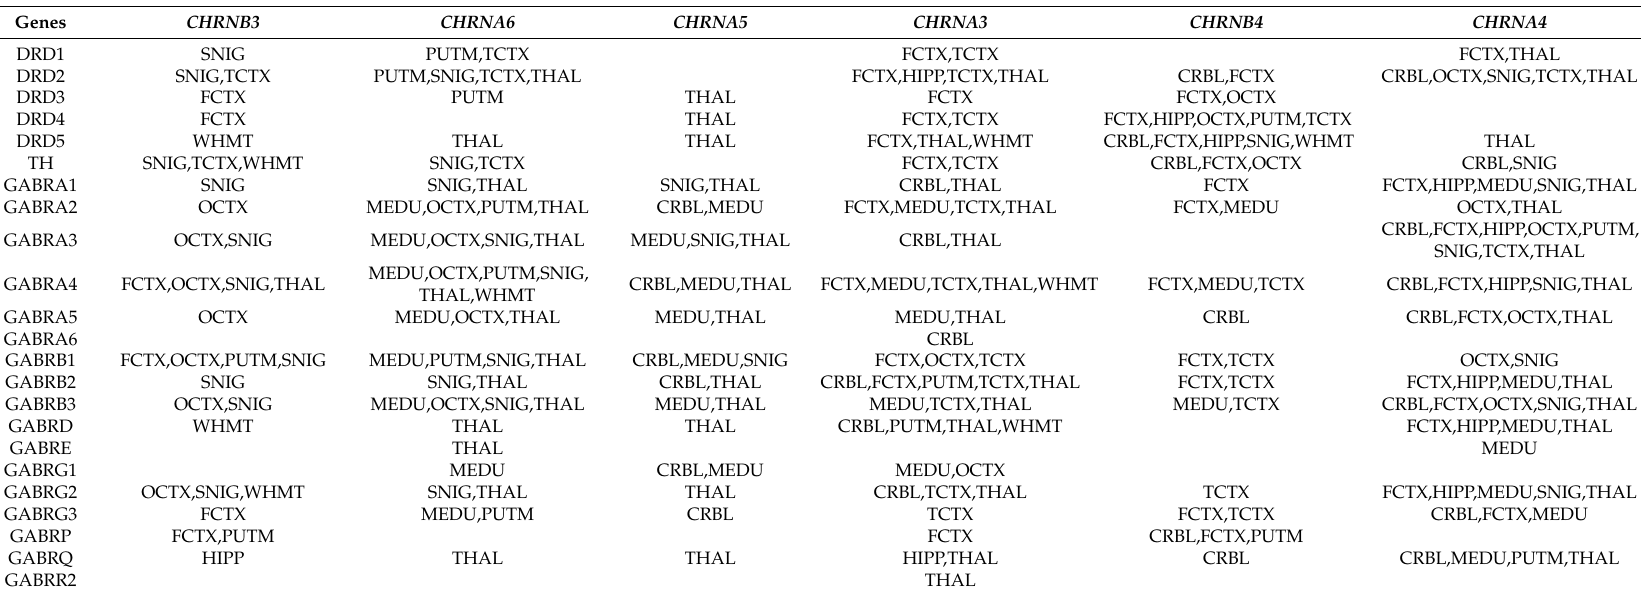
Table 2. Significant expression correlation between CHRNs and dopaminergic and GABAergic receptor genes in human brain.